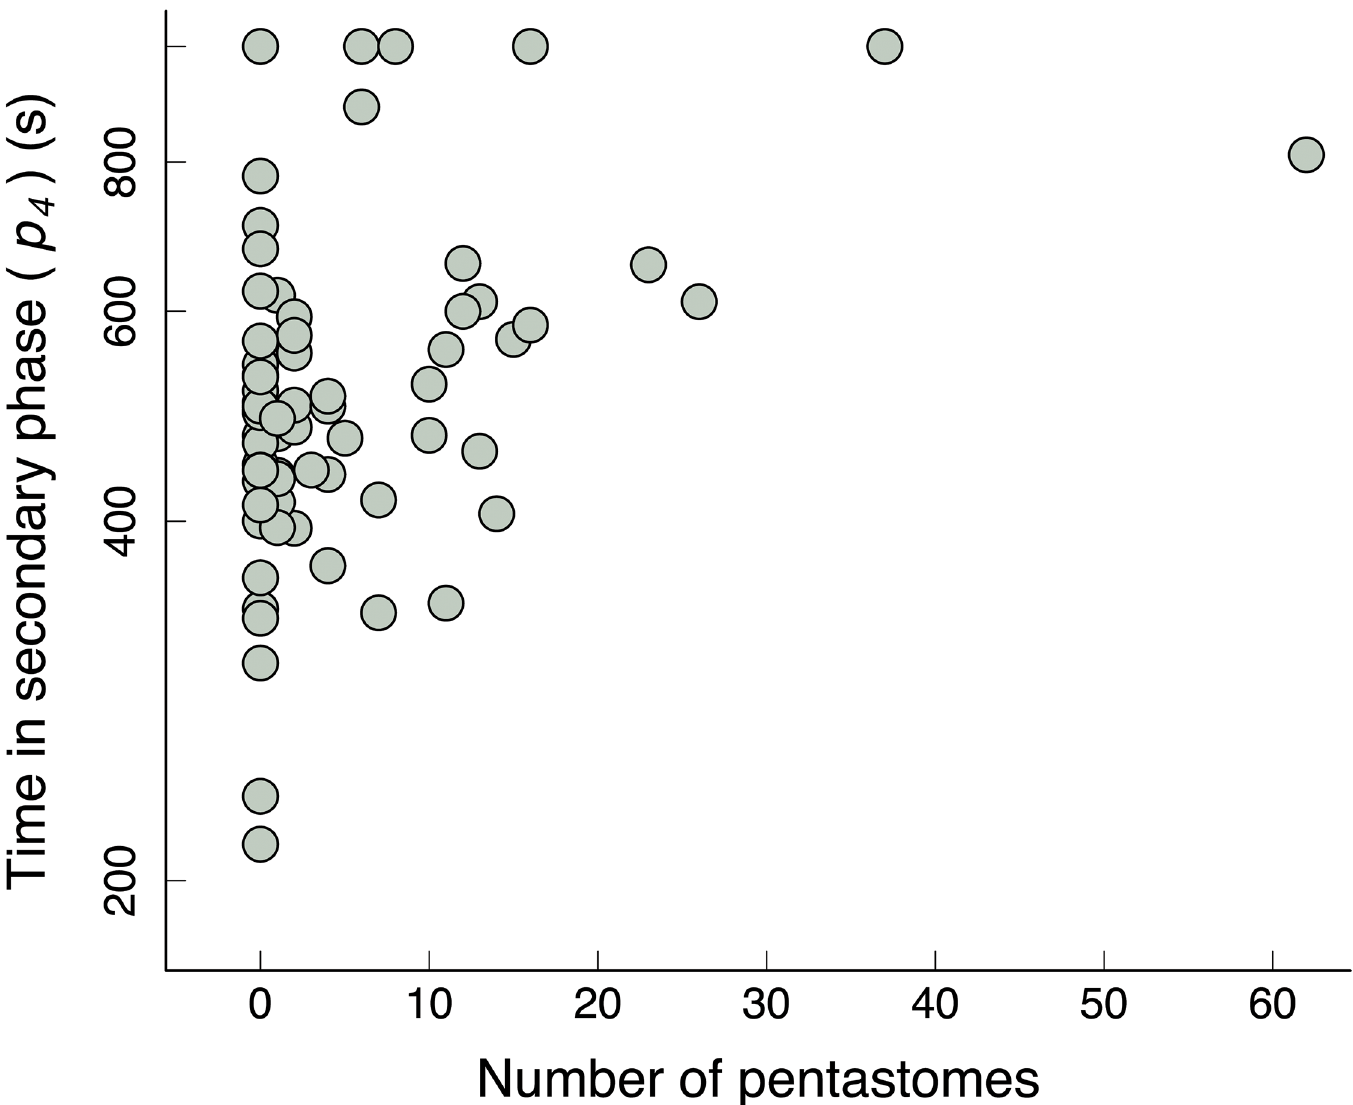
Fig 4. Relationship between time in secondary phase ( p 4 ) versus number of pentastomes for recently active geckos. Minimal regression model for recently active geckos ( n = 70): log (time in stationary phase) ( p 4 ) = (0.013 × number of pentastomes) + 6.164; model adjusted R 2 = 0.1424. Note log scale used on